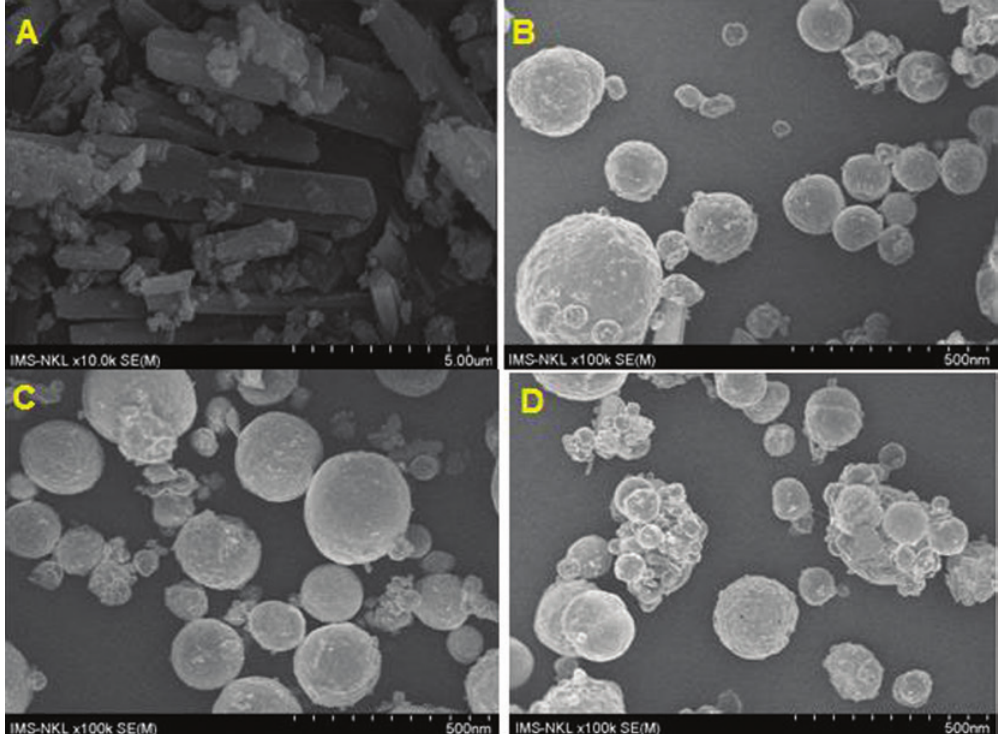
Figure 4: Field emission scanning electron microscopy images of Hq (A), PCHq nanoparticles using 20 wt% Hq (B), 30 wt% Hq (C), and 50 wt% Hq (D).